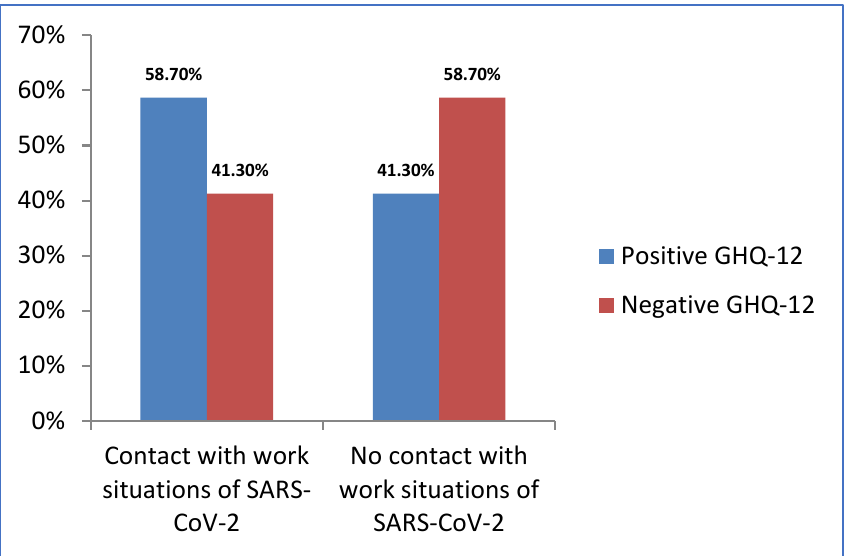
Figure 3. Results of GHQ-12 as a function of the situations of contact with SARS-CoV-2.